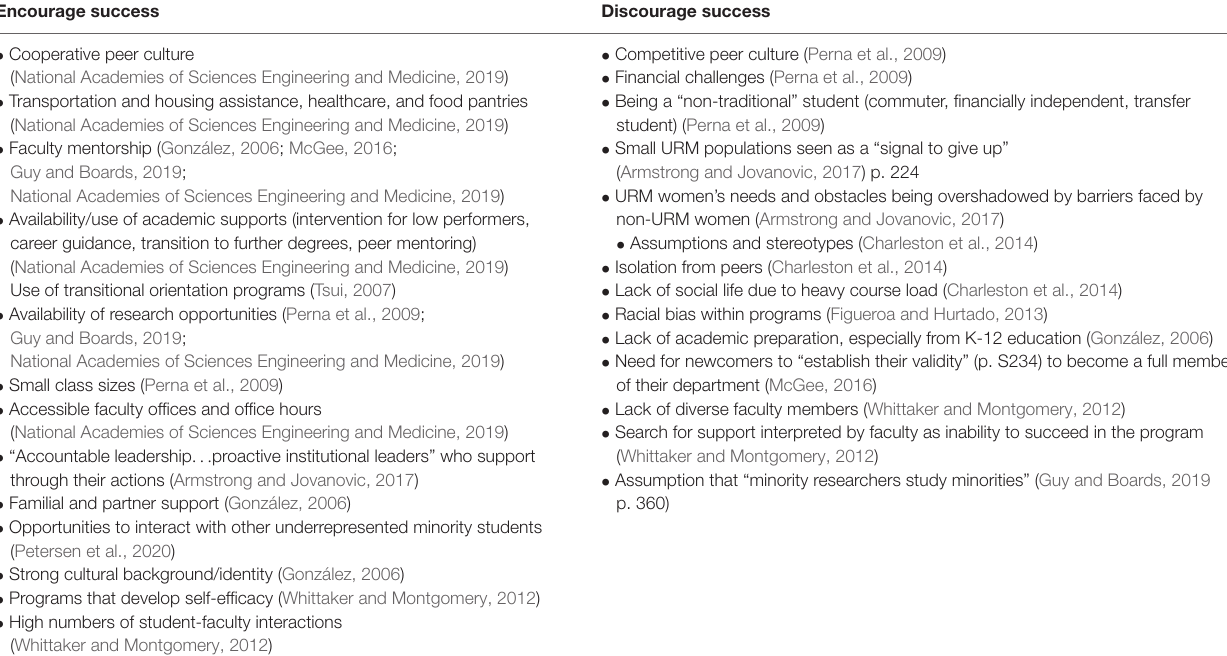
TABLE 1 | Summary of factors in the literature that encourage and discourage STEM success in academia for underrepresented minority